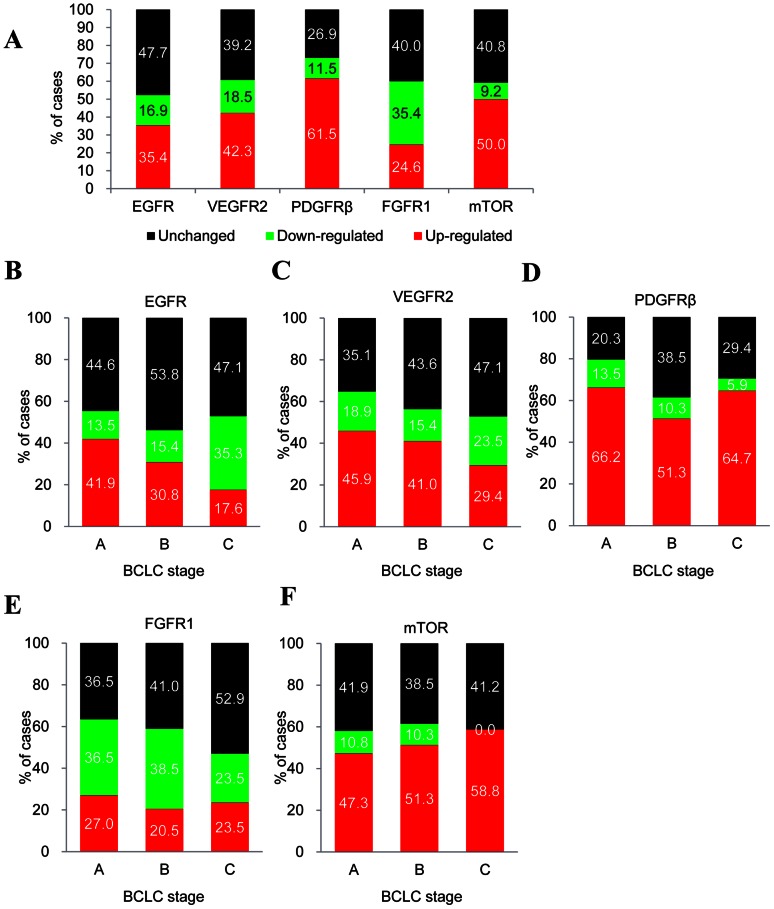
Expression frequency and timing of actionable molecules in HCC patients.(A) mRNA expression frequency of EGFR, VEGFR2, PDGFRβ, FGFR1, and mTOR in tumors; (B–F) Expression timing for EGFR, VEGFR2, PDGFRβ, FGFR1, and mTOR. Up-regulated: increased expression more than 2.0-fold in tumors than in non-tumors; down-regulated: reduced expression more than 2.0-fold in tumors than in non-tumors; unchanged: gene expression within −2.0∼2.0 fold in tumors than in non-tumors. The data are presented in % of cases.